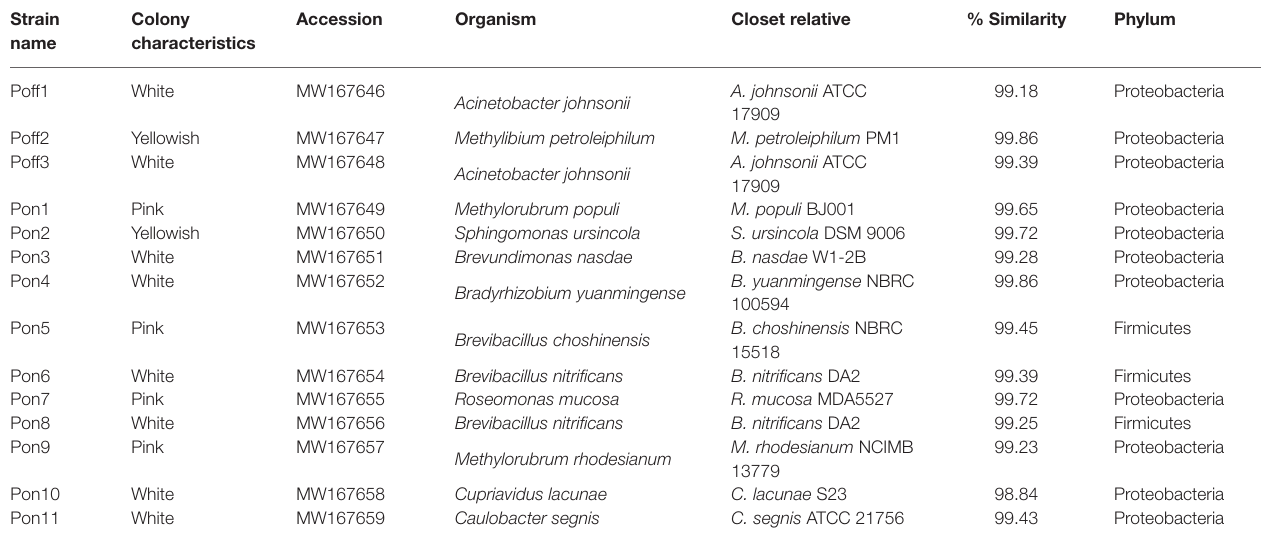
TABLE 1 | Identification of the heterotrophic plate count (HPC) bacterial isolated from this study using 16S ribosomal RNA (rRNA) gene. Strain Colony name characteristics